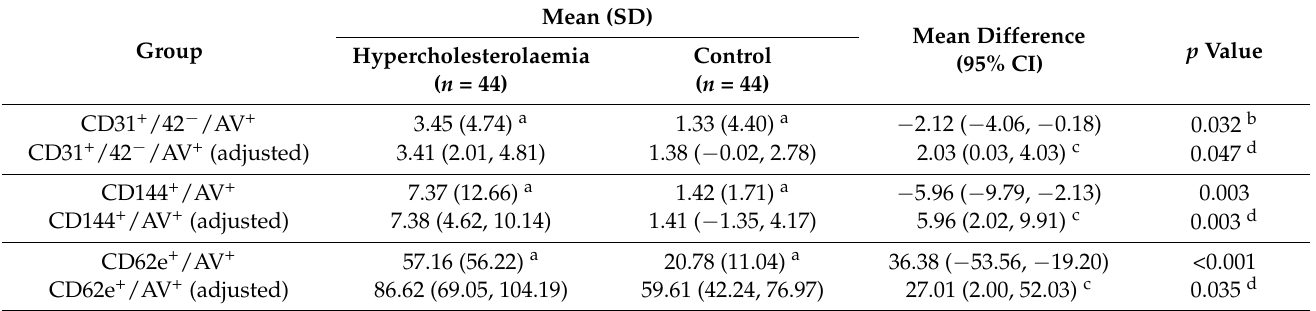
Table 2. Comparison of endothelium microparticles (EMP) between hypercholesterolemia patients and healthy controls with and without adjustment of possible